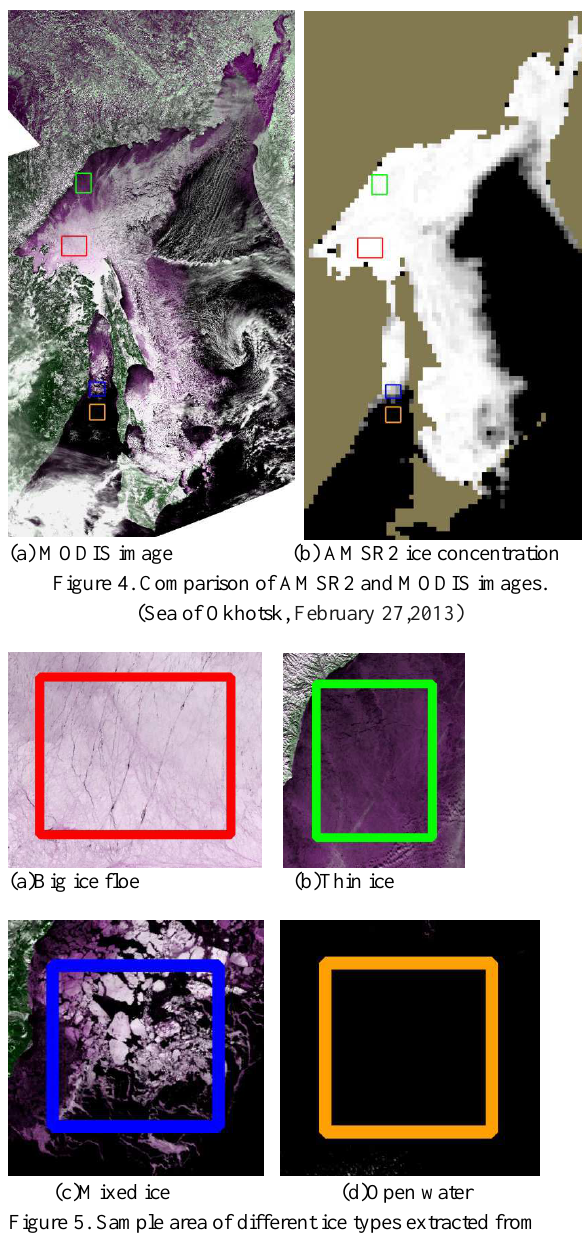
Figure 5. Sample area of different ice types extracted from MODIS image (Sea of Okhotsk, February 27, 2013)